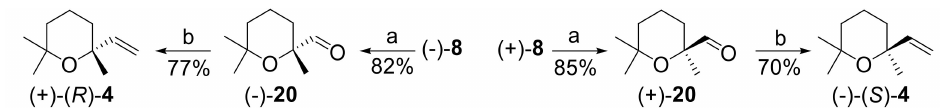
Figure 8. Synthesis of ( R )- and ( S )-linaloyl oxide 4 starting from ( R )- and ( S )-(2,6,6-trimethyltetrahydro-2 H -pyran-2-yl)methanol 8 , respectively. Reagents and conditions: ( a ) Py · SO 3 , dimethyl sulfoxide (DMSO), Et 3 N, rt, 2 h; ( b ) Zn, CH 2 I 2 , Me 3 Al, dry THF, 0 ◦ C, one